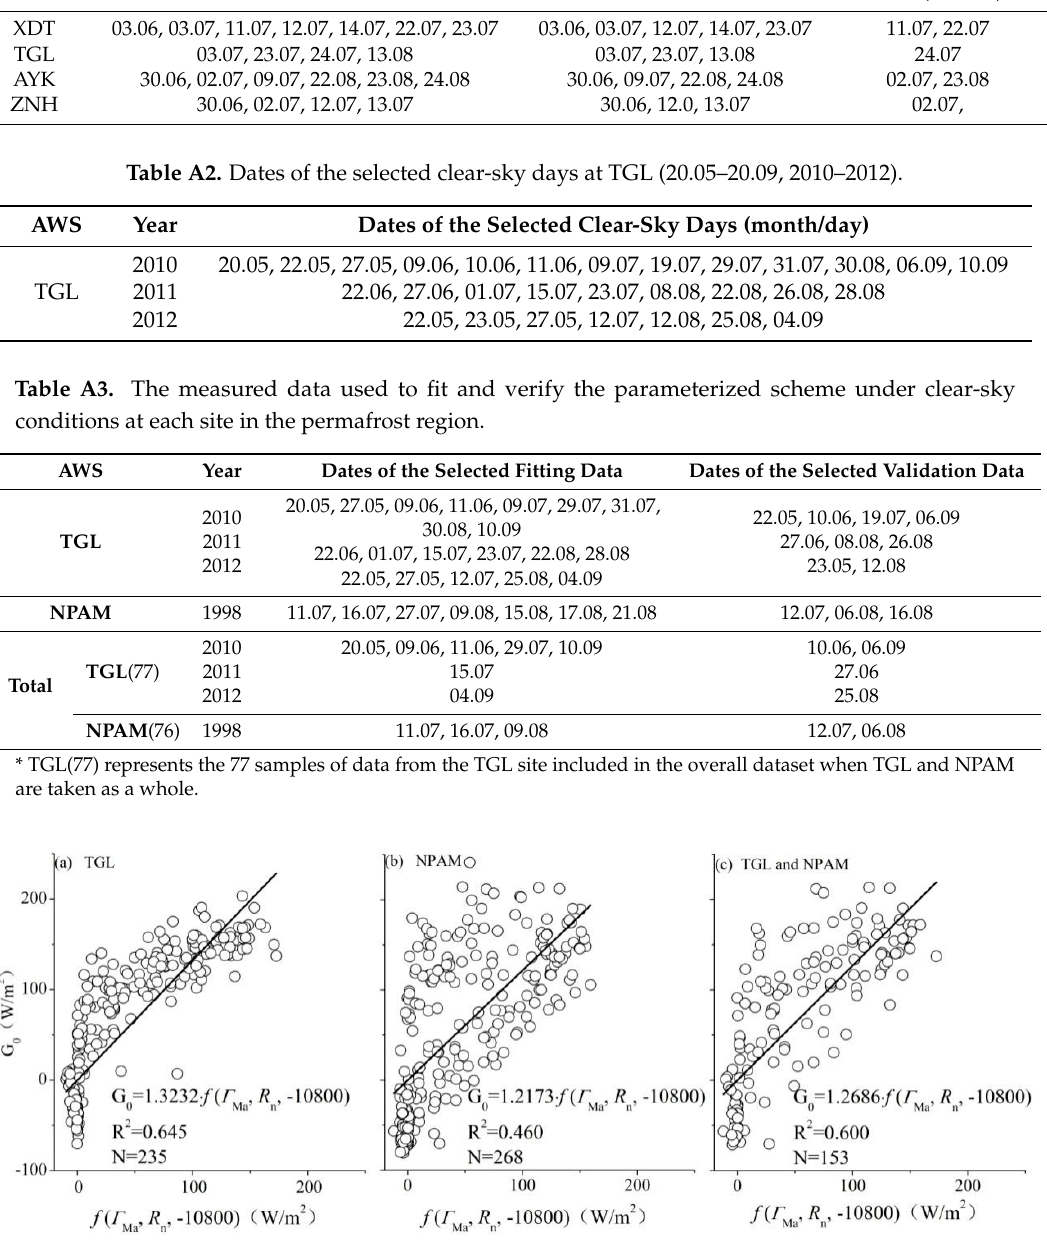
Table A1. Experimental data measured at XDT, TGL, AYK, and ZNH in 2014. Dates of the Selected Clear-Sky Days AWS